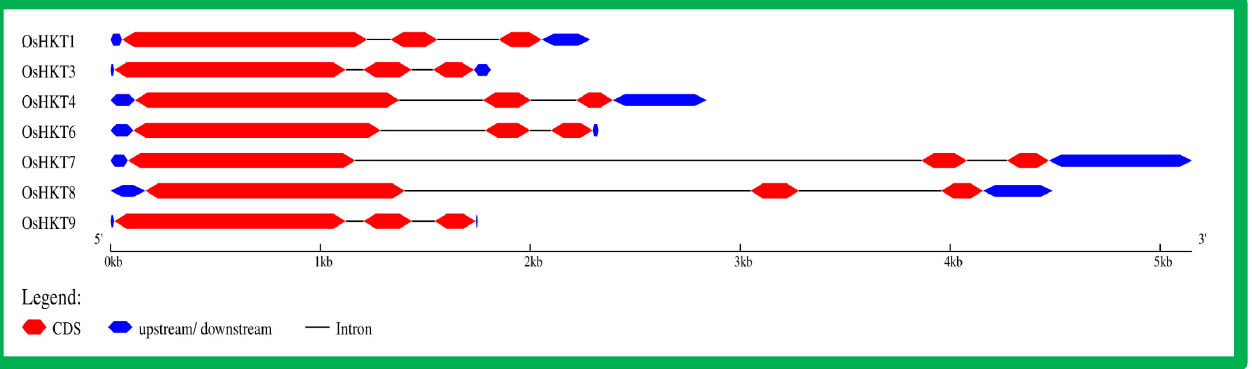
Figure 3. Gene structure analysis of OsHKT genes in rice. The red bars show CDS regions, whereas the grey lines represent introns. The blue bars at both ends display upstream/downstream regions.